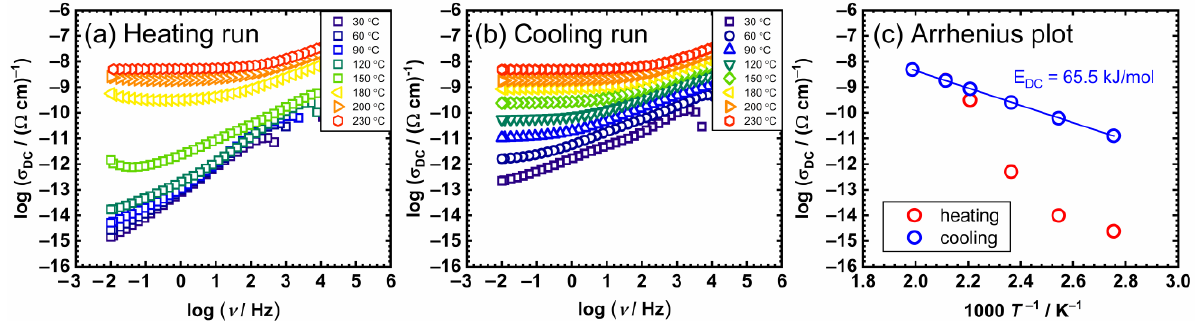
Figure 4. Conductivity spectra for [MoO 2 (L 1 )(MeOH)] in heating ( a ) and cooling ( b ) runs, and ( c ) temperature dependence of DC conductivity (log( σ DC ) vs. 1000/T) for both runs (red circle—heating, blue circle—cooling).